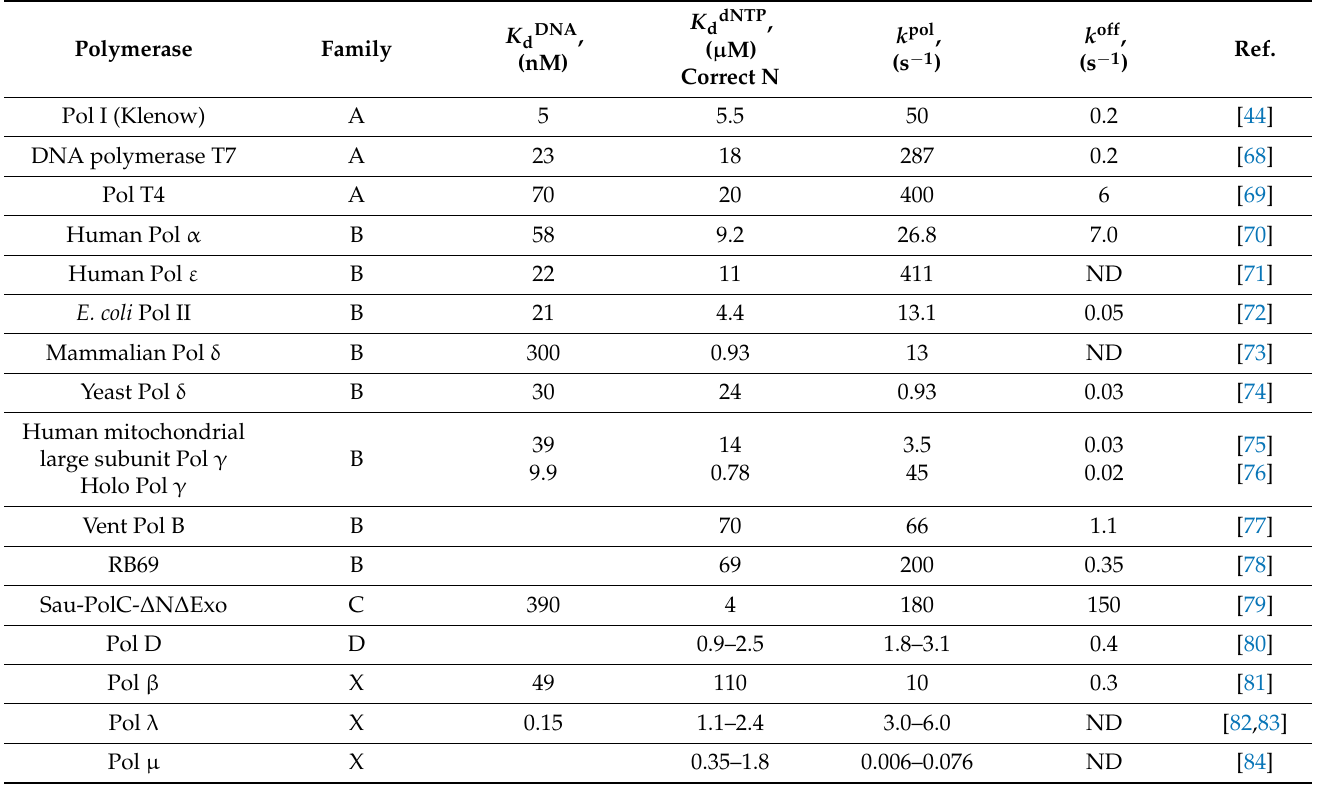
Table 3. A comparison of kinetic parameters of various polymerases.